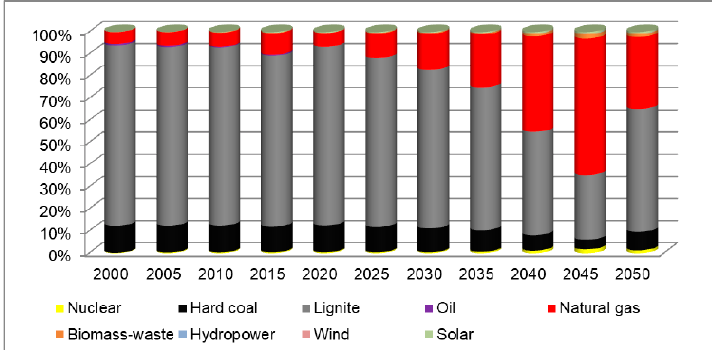
Figure 5. Determinants of greenhouse gas (GHG) emissions of current and future electricity generation in the Czech Republic based on IPCC method.